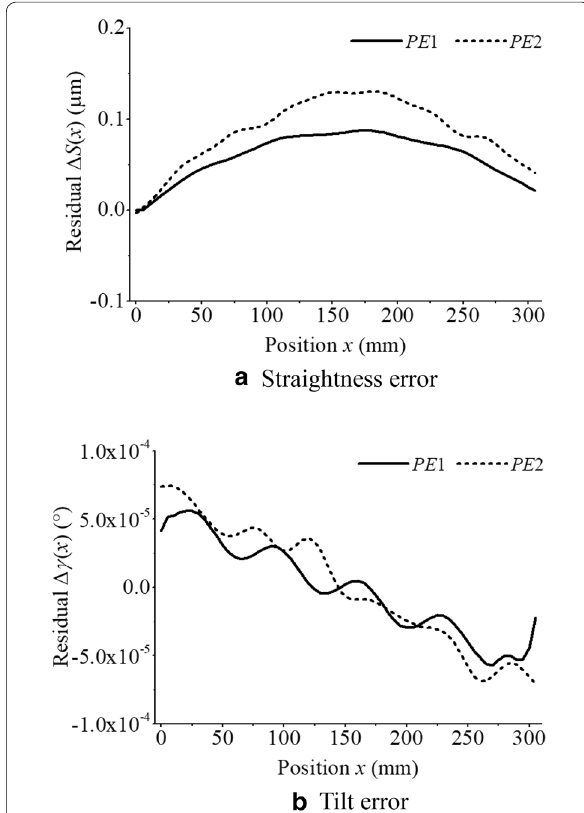
Figure 5 Residuals caused by the positioning errors PE 1 and PE 2 as σ 0 =